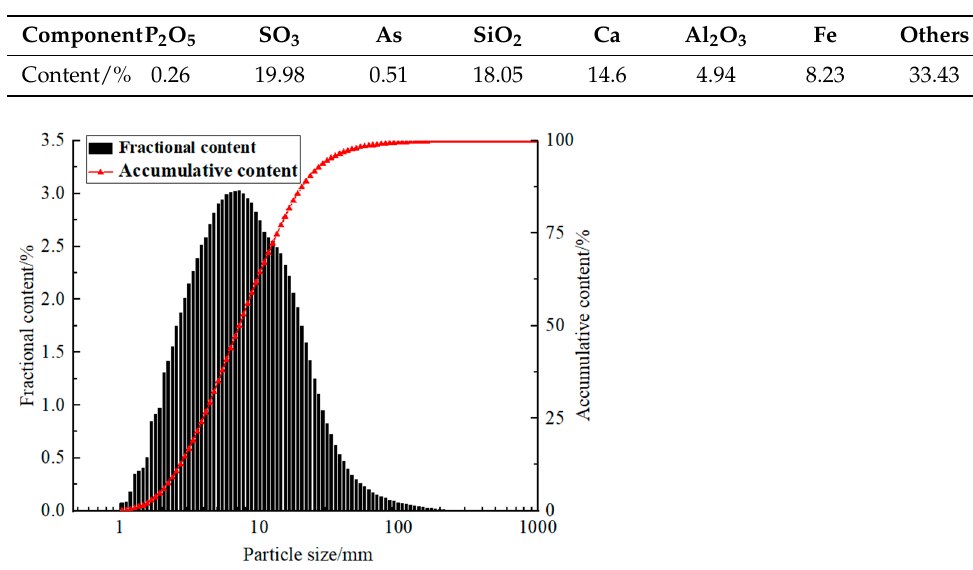
Table 2. Main chemical compositions of neutralization slag.